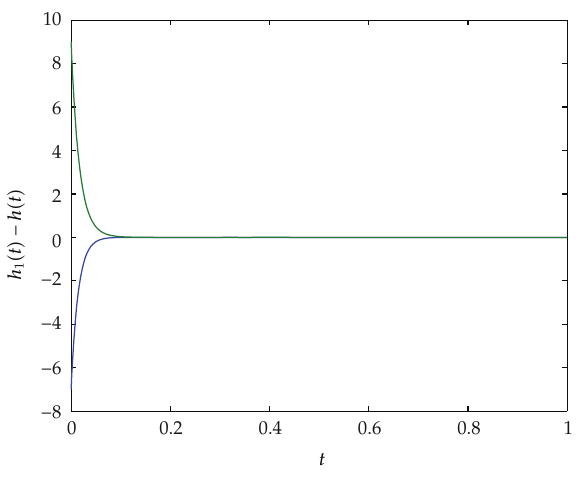
Figure 8: Error signal of h 1 (cid:3) t (cid:4) − h (cid:3) t (cid:4)